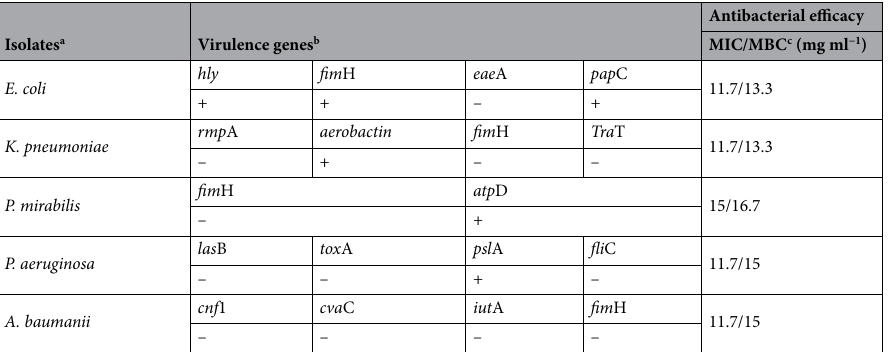
Table 3. The relation between virulence genes and antibacterial activity of Acacia nilotica extract for isolated uropathogens. a Different isolated bacteria from urine samples; Escherichia coli , Klebsiella pneumoniae , Proteus mirabilis , Pseudomonas aeruginosa , Acinetobacter baumannii. b Present ( +), absent (–). c Minimal inhibitory concentration/ minimal bactericidal concentration of the extract against isolated uropathogens represented in mg ml −1 .